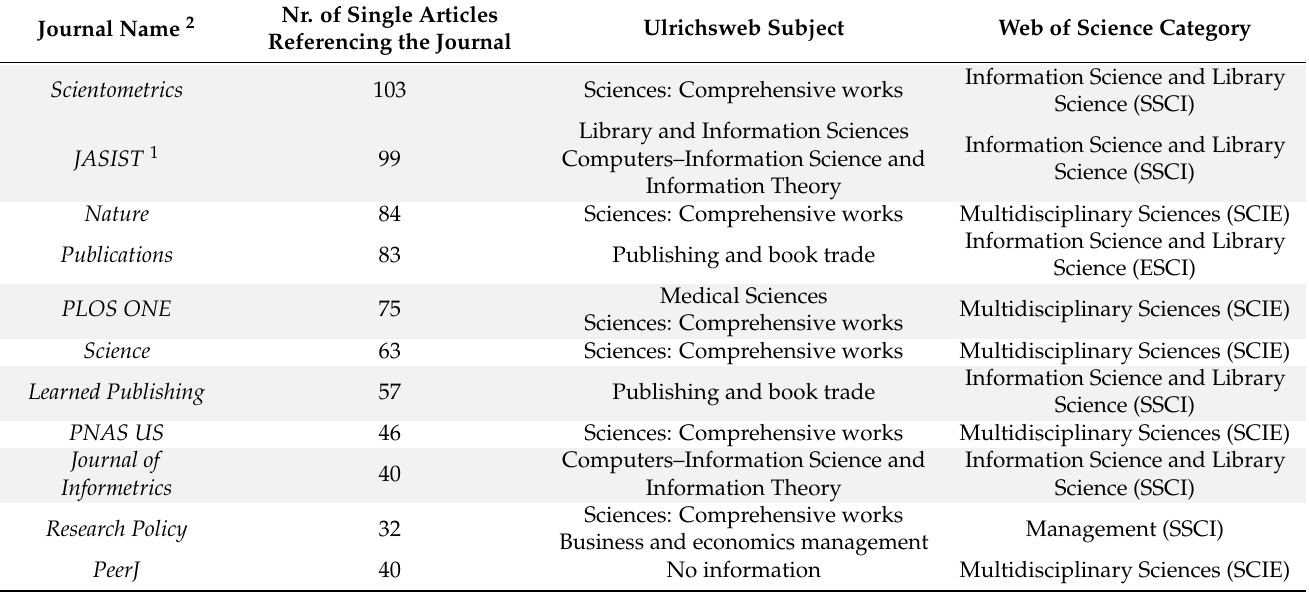
Table 6. Top journals cited by 10% of the 322 articles (single count).